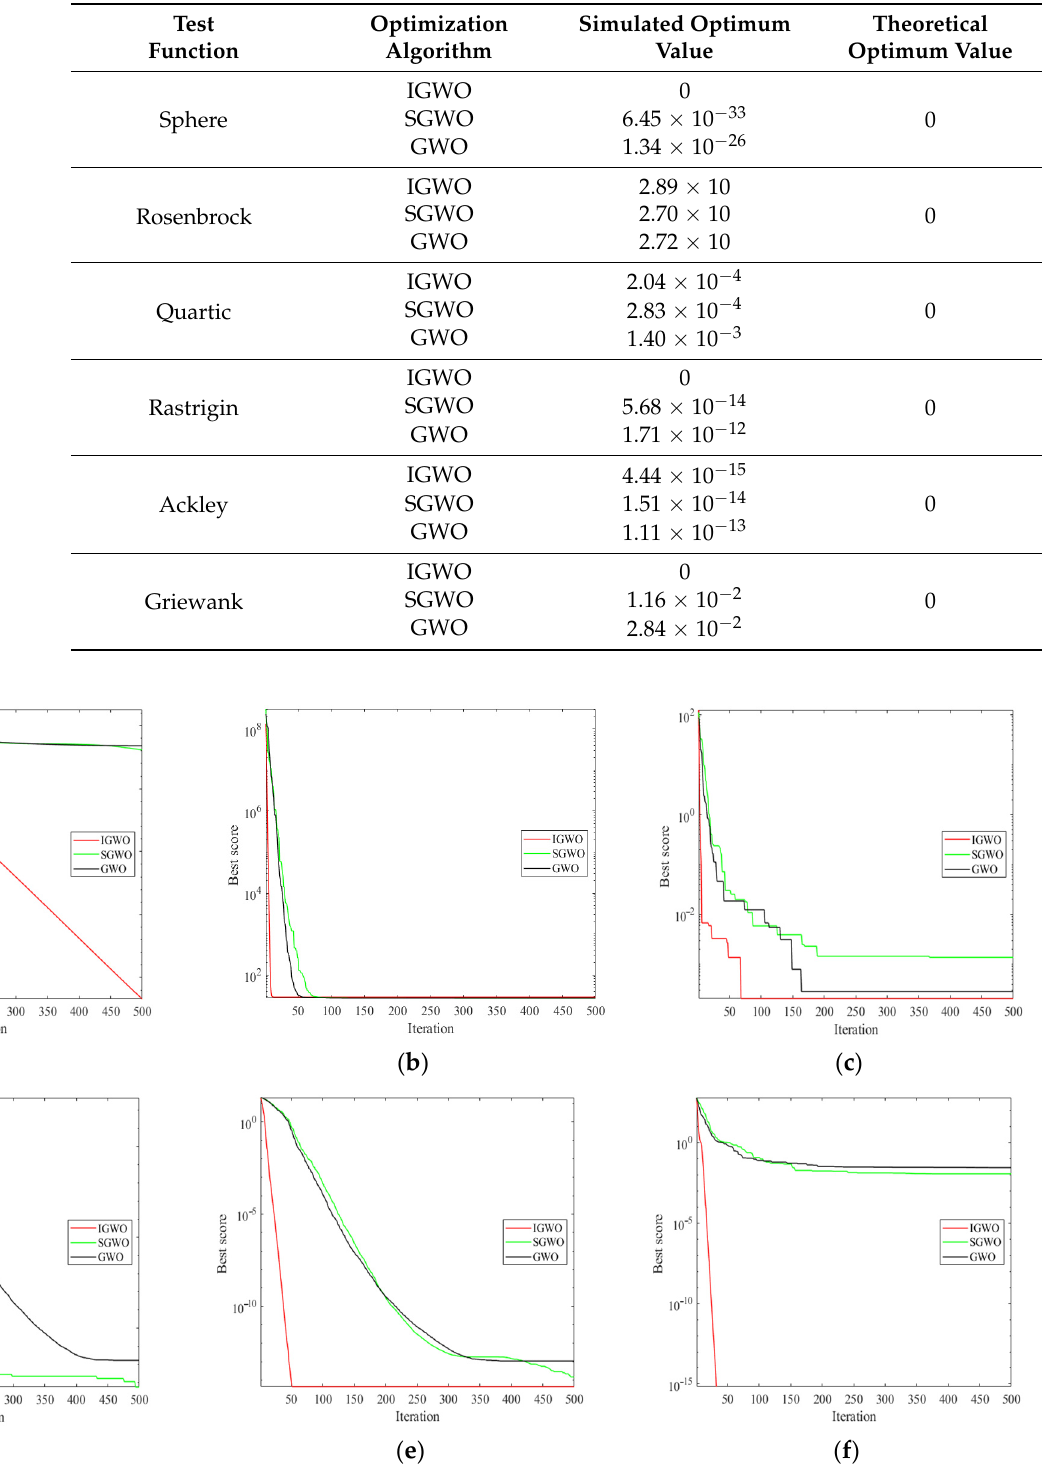
Figure 2. Convergence curves of the test function with the three optimization algorithms: ( a ) Sphere; ( b ) Rosenbrock; ( c ) Quartic; ( d ) Rastrigin; ( e ) Ackley; ( f ) Griewank.